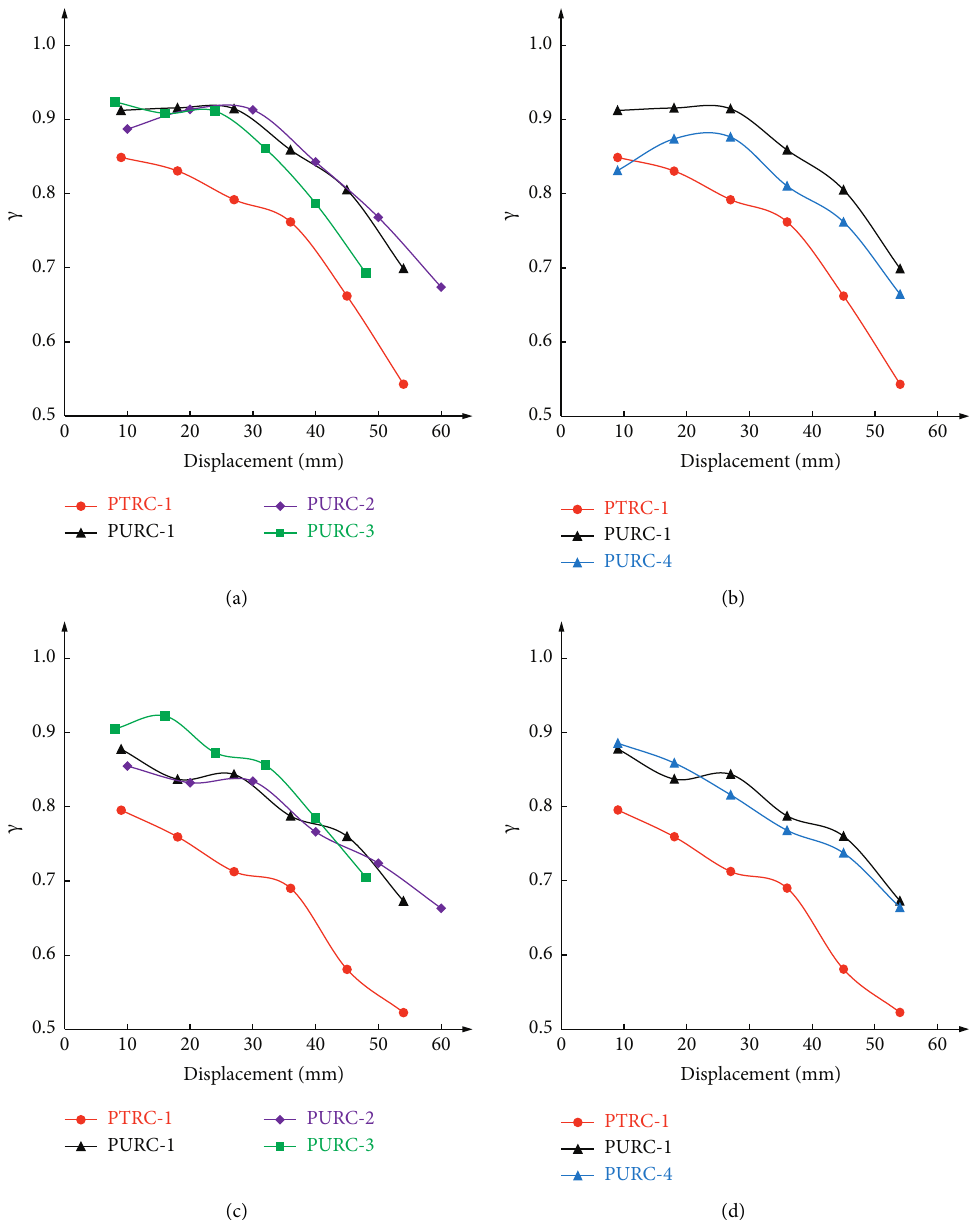
Figure 10: Self-centering capability coefficient of specimens. Note . (a) and (b) present the self-centering capability coefficients of specimens under the forward loading; (c) and (d) present the self-centering capability coefficients of specimens under the reverse